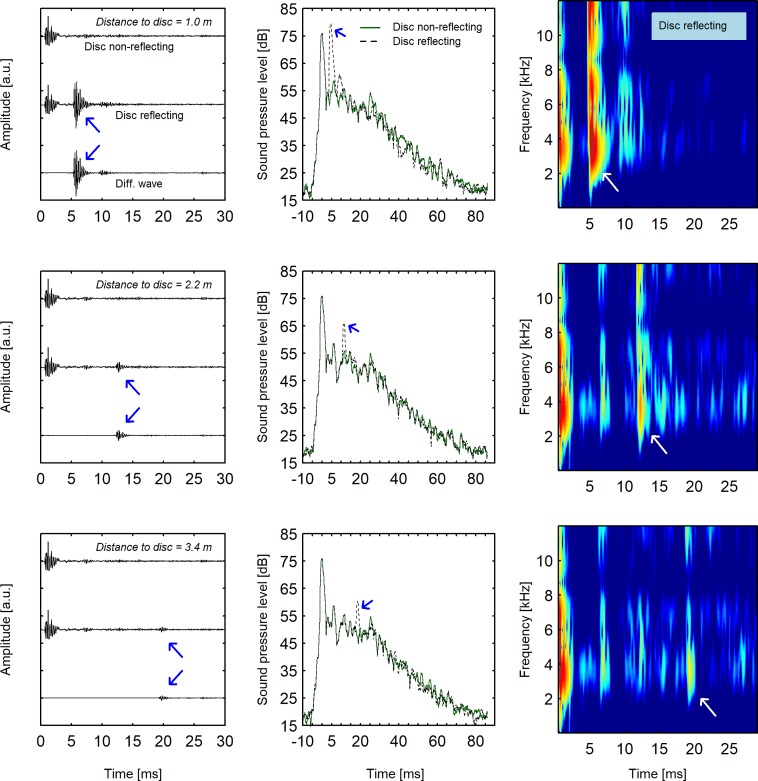
Acoustics of direct and reflected click.Visualization of signals recorded with the Echobot’s disk at 1.0 m, 2.2 m, and 3.4 m are shown in the upper, middle, and lower row of panels, respectively. Arrows indicate the position of the reflected click. Left panels: Amplitude (arbitrary unit) as a function of distance from the reflecting disk. In each panel, the three curves refer to recordings with the disk in non-reflecting position (upper), the disk in reflecting position (middle), and the wave difference obtained by subtracting reflecting from non-reflecting. Middle panels: Sound pressure level (1 ms running rectangular window) as a function of distance to the disk. The green solid curve refers to recordings with the disk in non-reflecting position; the dashed curve refers to recordings with the disk in reflecting position. Note that the time scale (x-axis) is longer than the time scale of the left and right panels. Right panels: Spectrograms (frequency vs. time, with color-coded amplitude) for recordings with the disk in reflecting position.